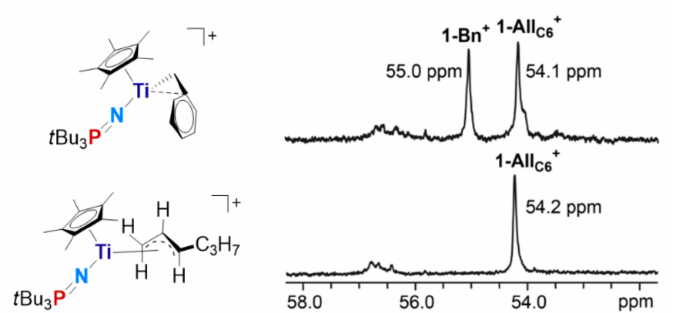
Figure 5. 31 P NMR (toluene- d 8 , 298 K) spectra of the Ti(IV)-benzyl (‘ 1-Bn +’ ) and Ti(IV)-allyl (‘ 1- All C6+ ’ ) intermediates observed under polymerization conditions by reacting 1 (cid:48) -tBu with ~10 (bot- tom) or >100 (top) eq. of 1-hexene. Reproduced with permission from Reference